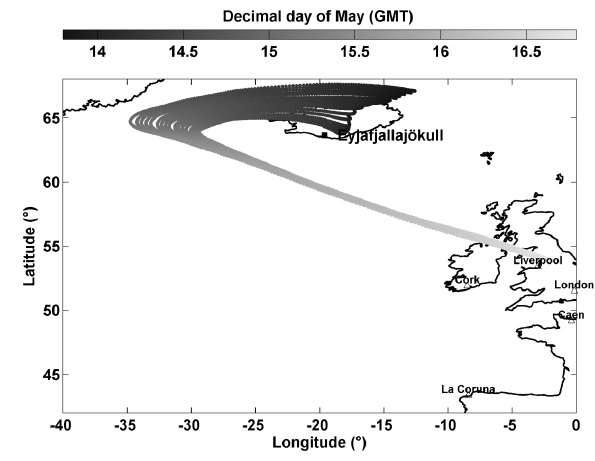
Figure 7: The same as Figure 6 for 16 May 2010. 603 Fig. 7. The same as Fig. 6 for 16 May